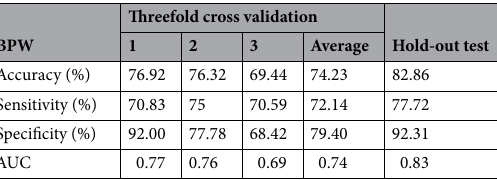
Table 3. Hold-out MLP analysis results for comparisons of BPW indices between AD patients and control subjects.